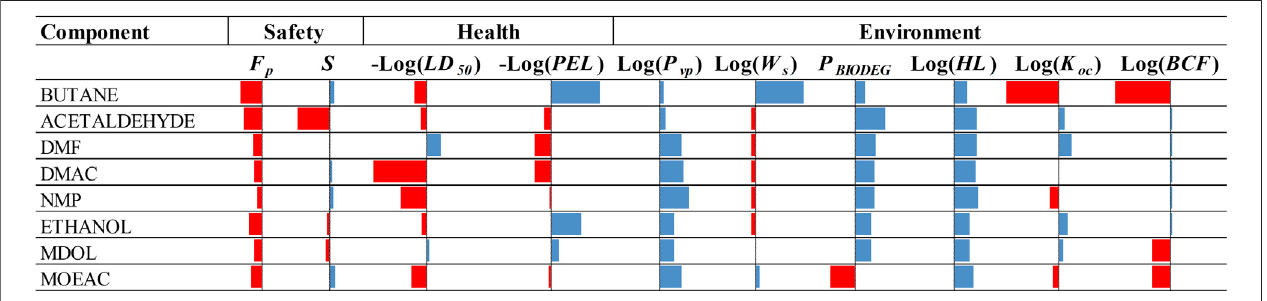
FIGURE 8 | Comparison of selected working fl uids with NH 3 in terms of safety, health and environmental impact properties. Red bars pointing left indicate worse performance, whereas blue bars pointing right indicate better